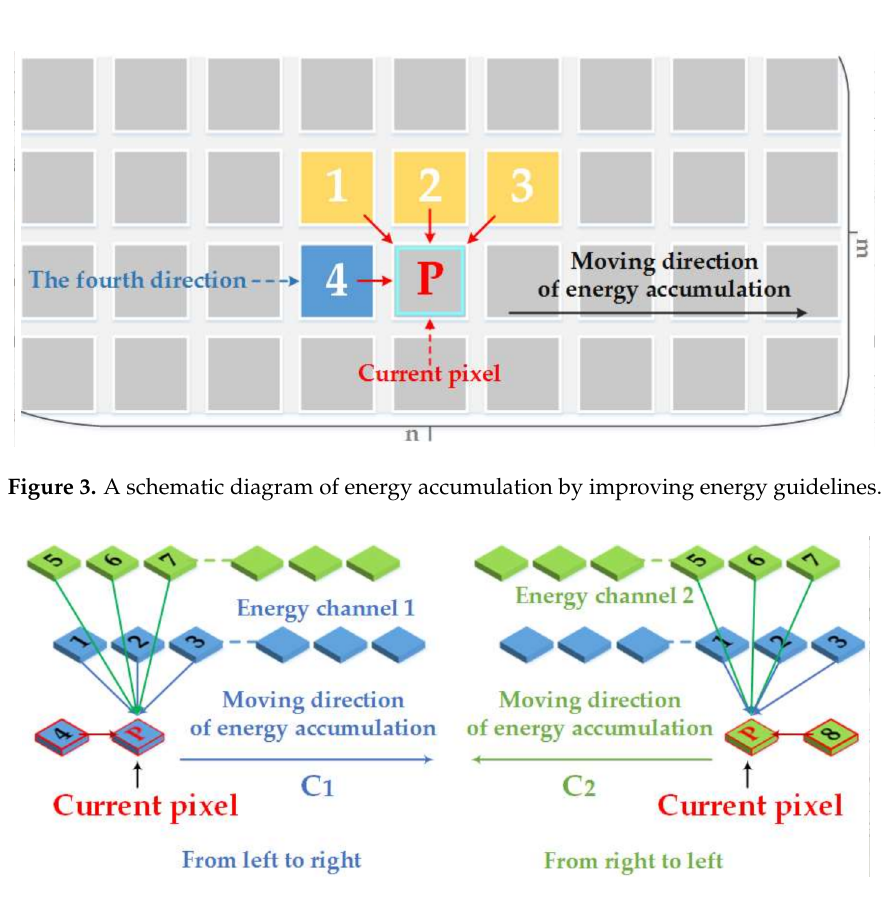
Figure 4. A schematic diagram of our search